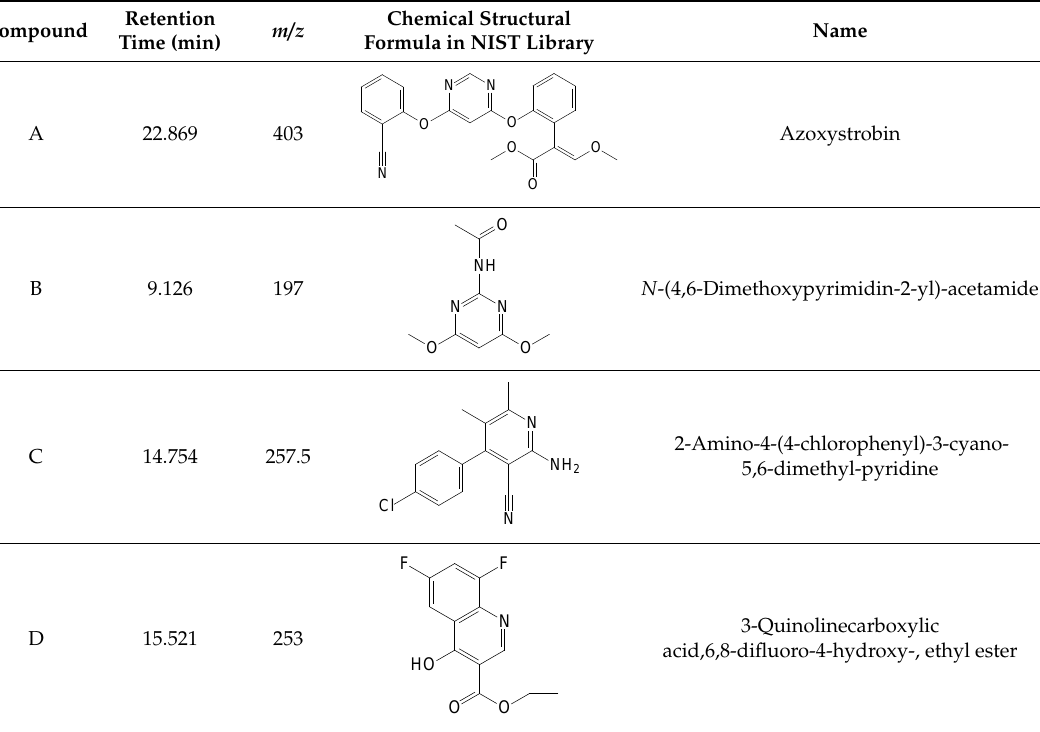
Table 3. Chromatographic properties of azoxystrobin metabolites during degradation by strain SH14. Compound